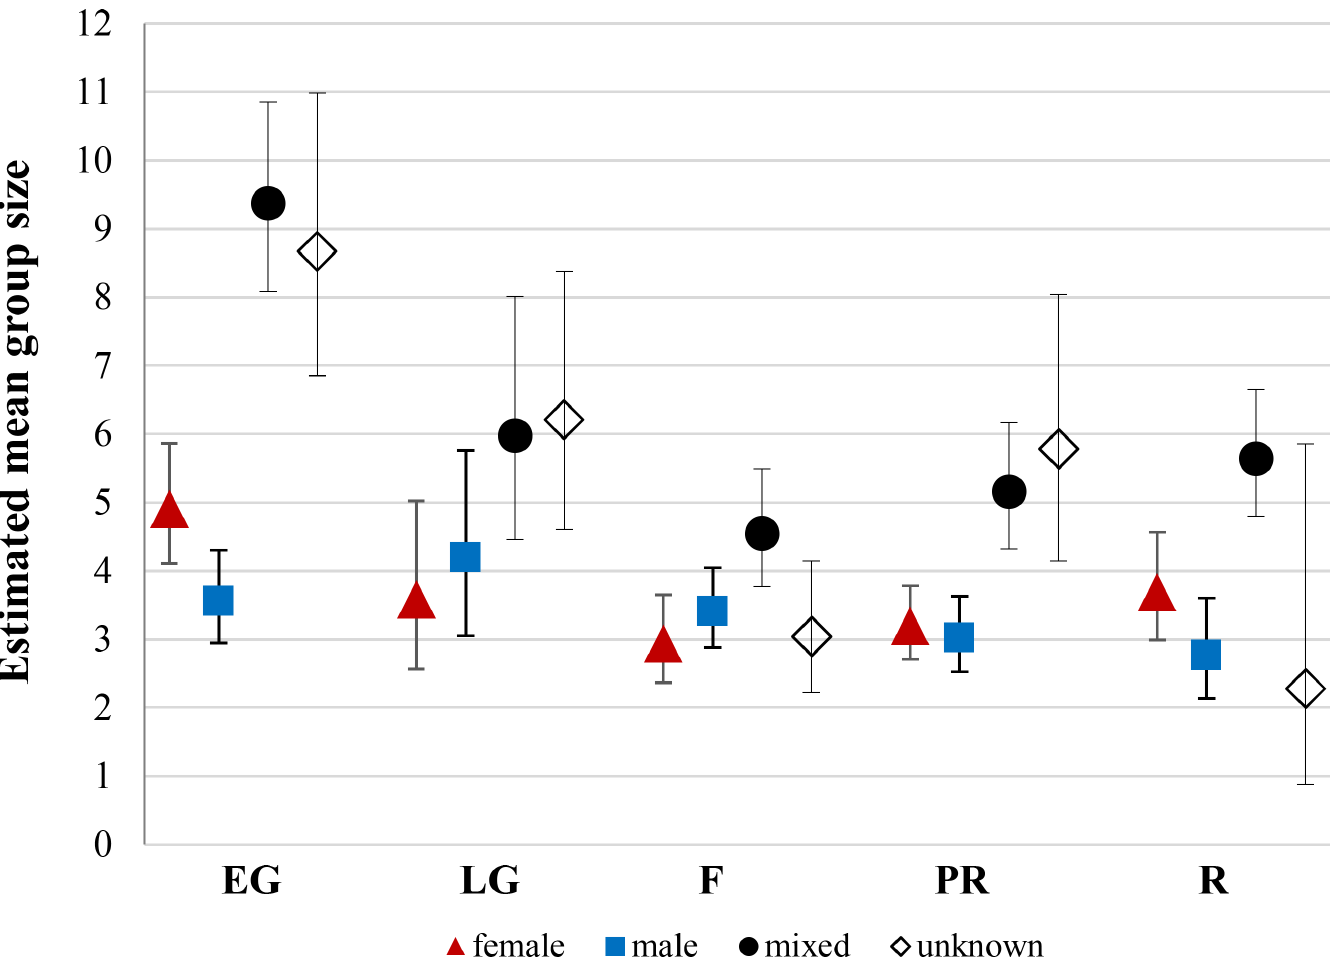
Fig 1. Predicted seasonal variation of mean group size by group type. Bars are 95% confidence intervals. EG = early gestation, LG = late gestation, F = fawning, PR = pre-rut, and R =